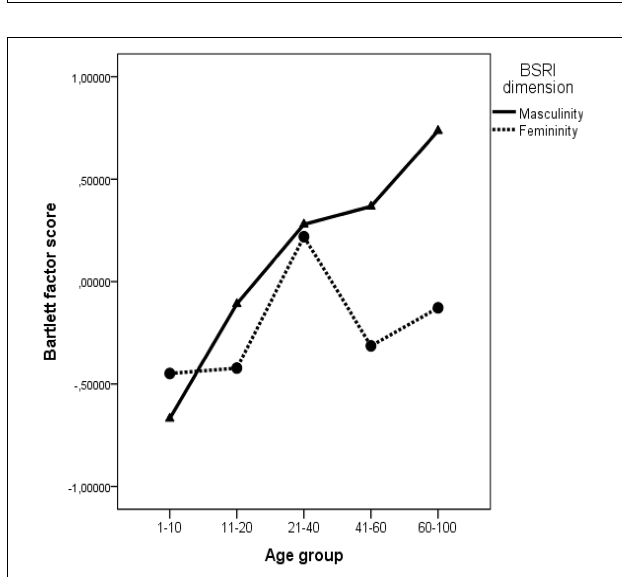
FIGURE 5 | Evolution of masculinity and femininity with age.